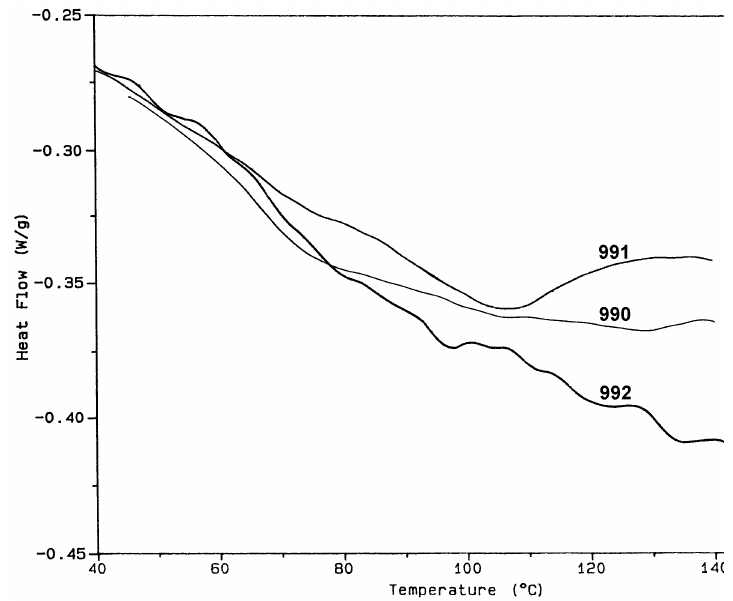
Fig. 7 DSC diagram of obtained hybrids from MMA-AlAcAc copolymers (s.990: 4g TIP; s.991: 2g TIP; s.992: 6g